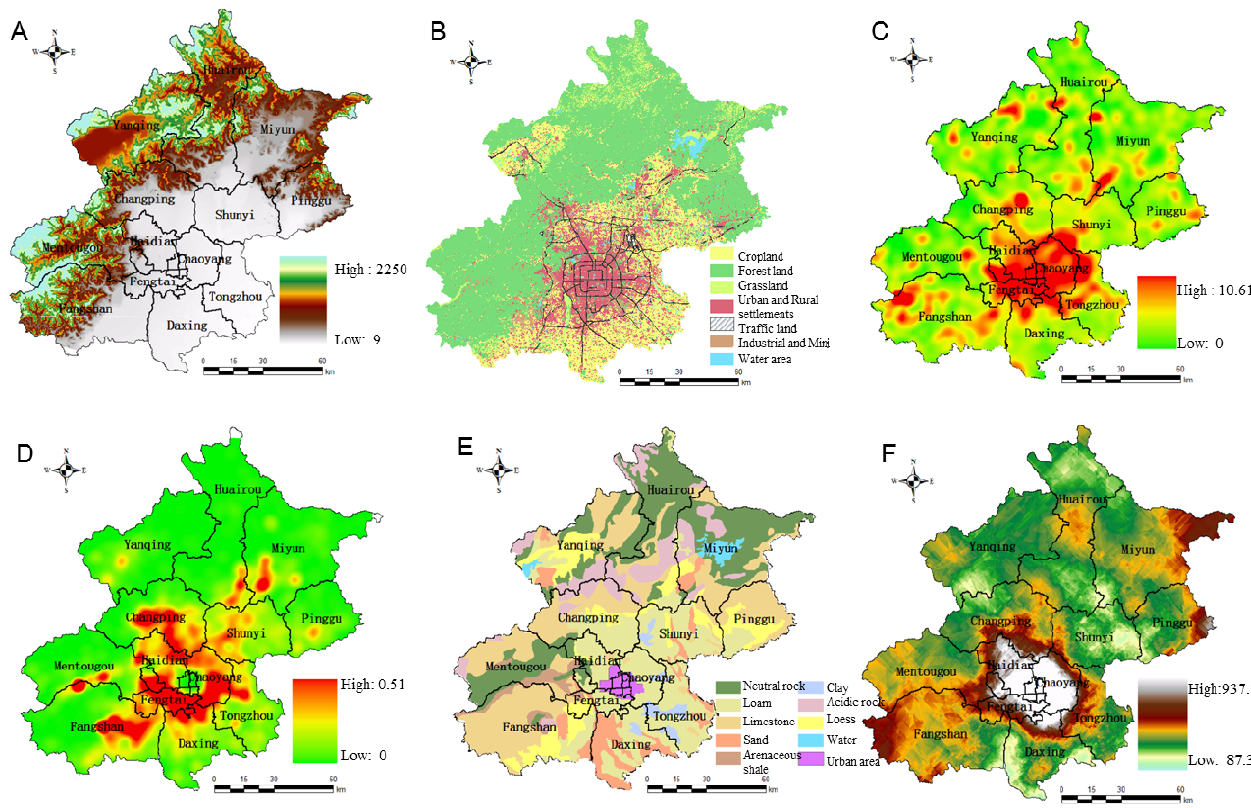
Figure 2. Main spatial data on the map of Beijing. ( A ) Elevation; ( B ) Actual land-use map; ( C ) Road Density; ( D ) Industrial and Mining Land Density; ( E ) Map of soil-forming parent material; ( F ) Map of potential ecological risk index